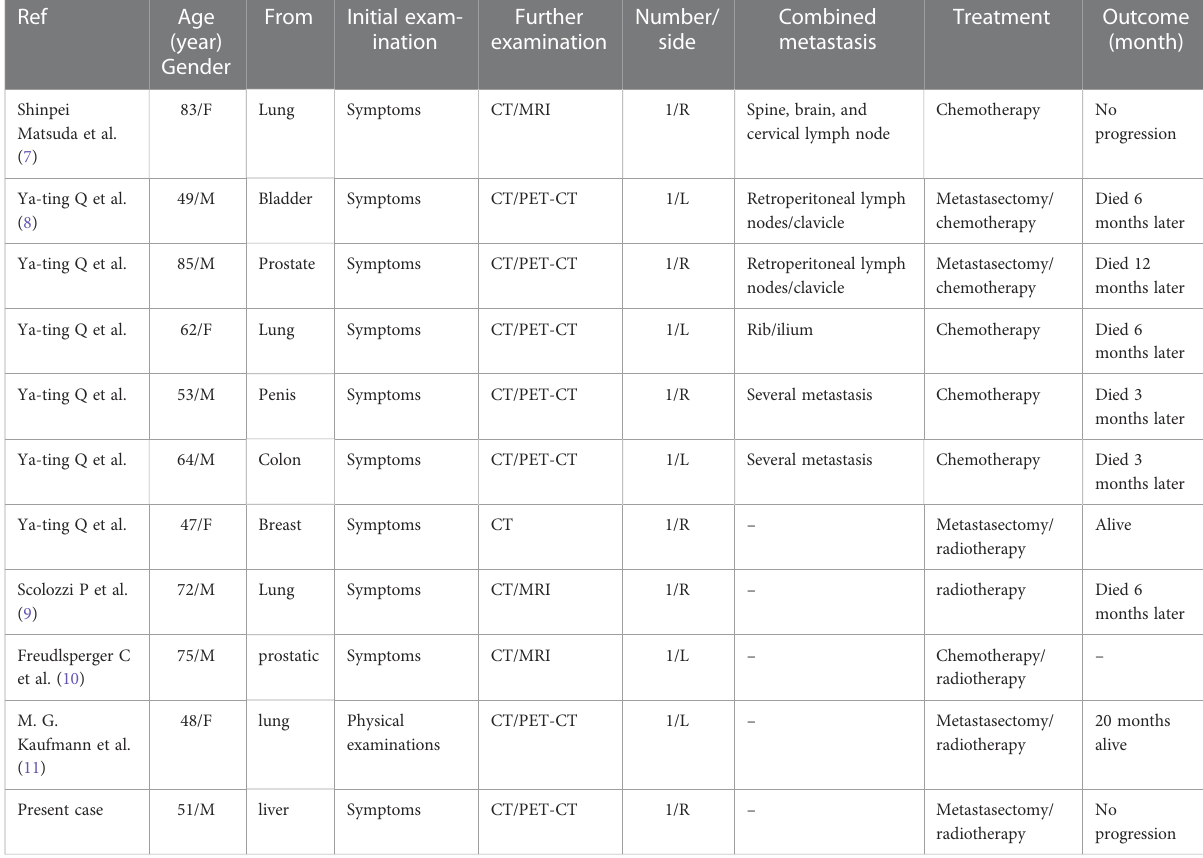
TABLE 1 Clinical characteristics of cases with condylar metastasis from